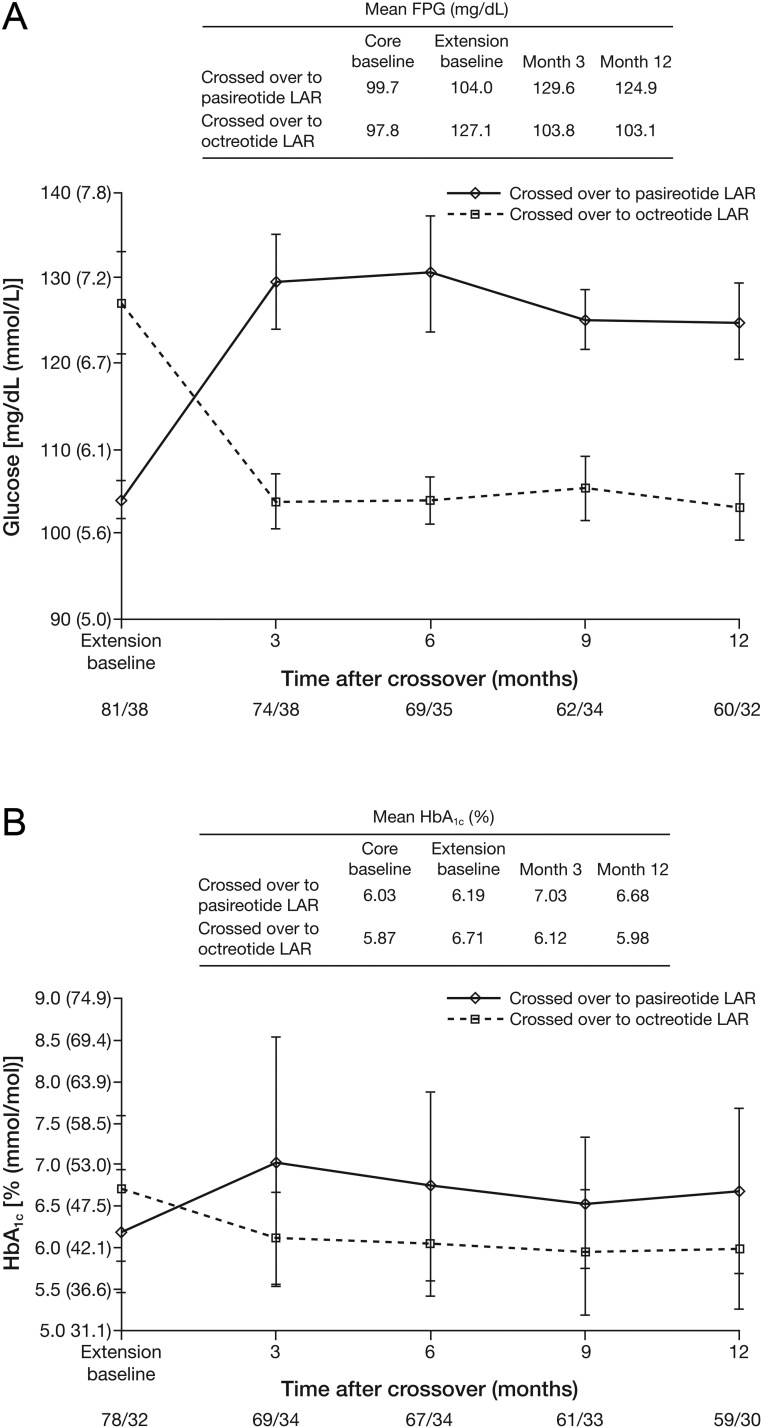
Change in (A) mean glucose levels and (B) mean HbA1c after crossover in study C2305. Numbers below the horizontal axes refer to numbers of patients who crossed over to long-acting pasireotide/crossed over to long-acting octreotide. HbA1c, glycated hemoglobin; LAR, long-acting release.